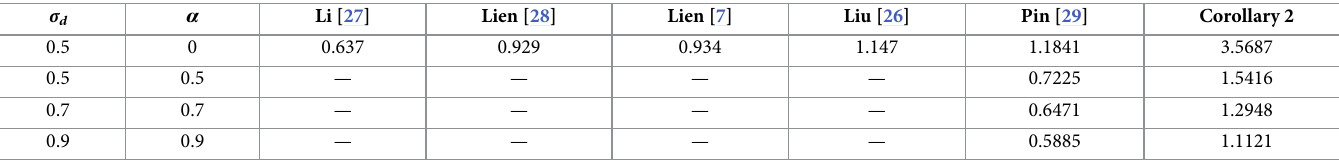
Table 3. The maximum allowable bounds of σ 2 for σ d and α of Example 3.